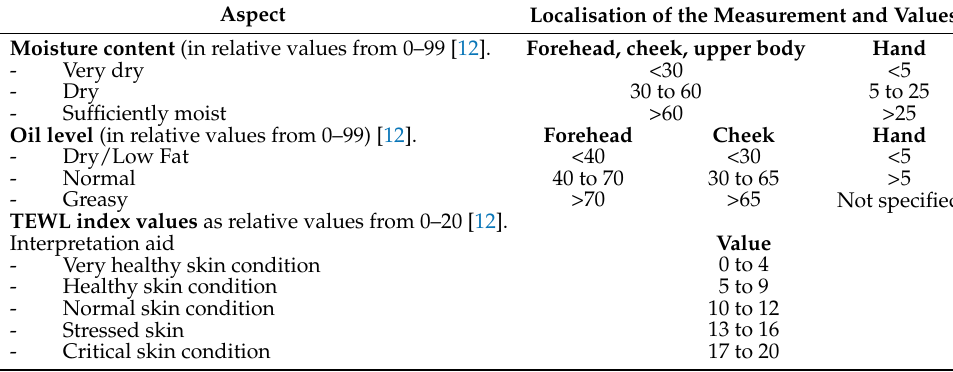
Table 1. Reference values for skin analysis. Aspect Localisation of the Measurement and Values Moisture content (in relative values from 0–99 [12]. Forehead, cheek, upper body Hand